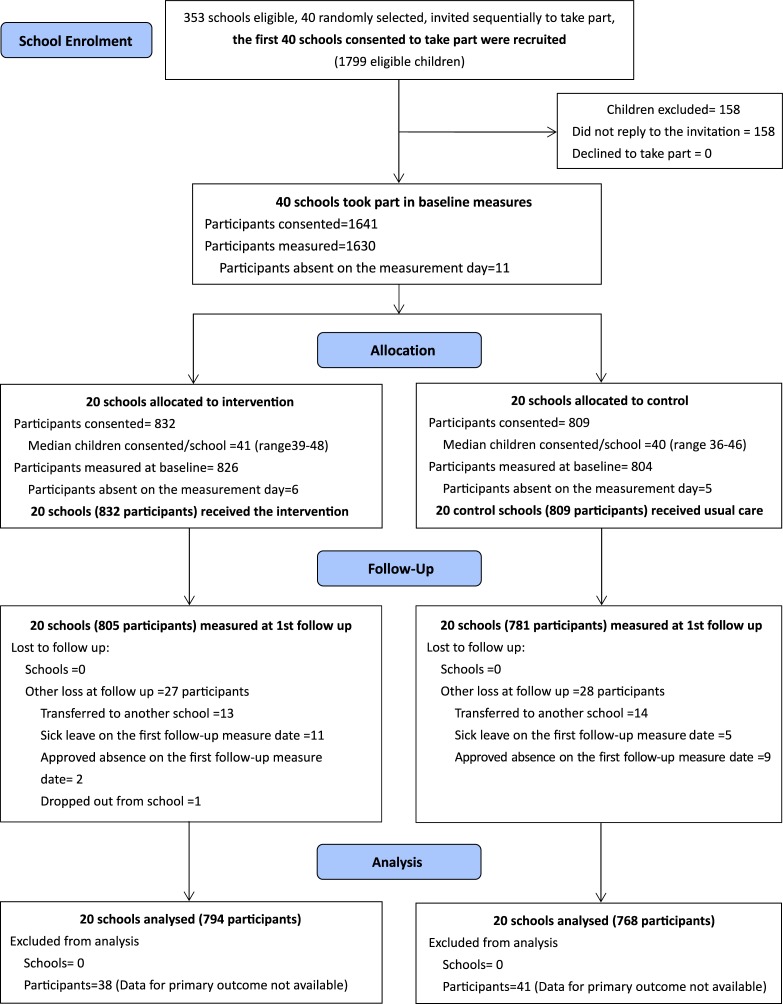
Participants flow chart of the CHIRPY DRAGON trial.CHRIPY DRAGON, Chinese Primary School Children Physical Activity and Dietary Behaviour Changes Intervention.